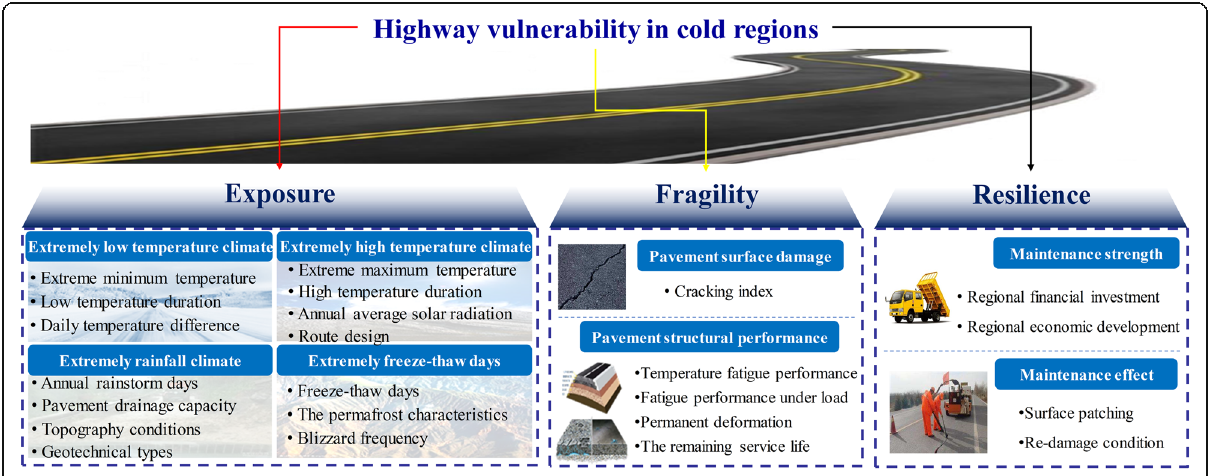
Fig. 1 Assessment index system of highway vulnerability in cold regions